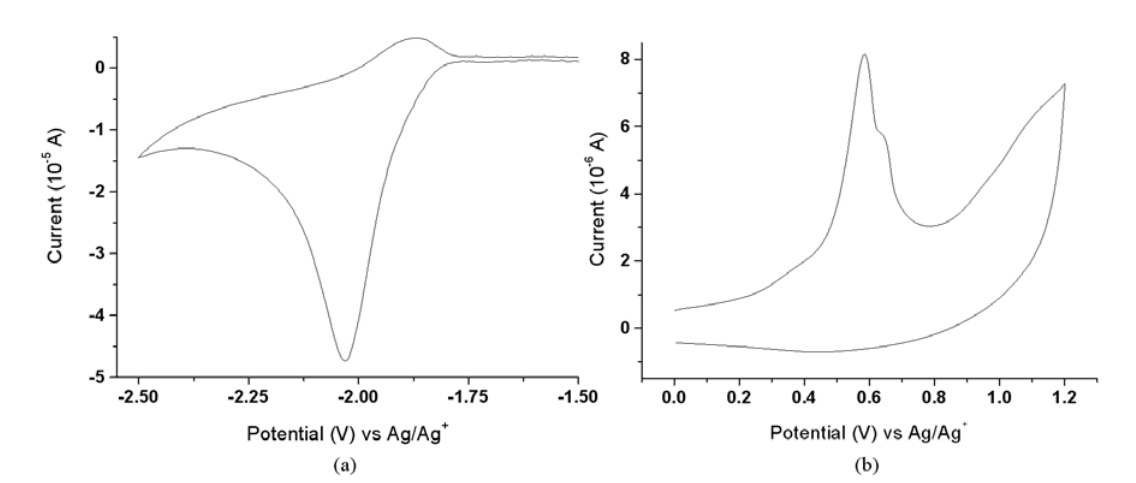
Fig. 5 The CV curves of compound 2 : (a) reduction and (b) oxidation.